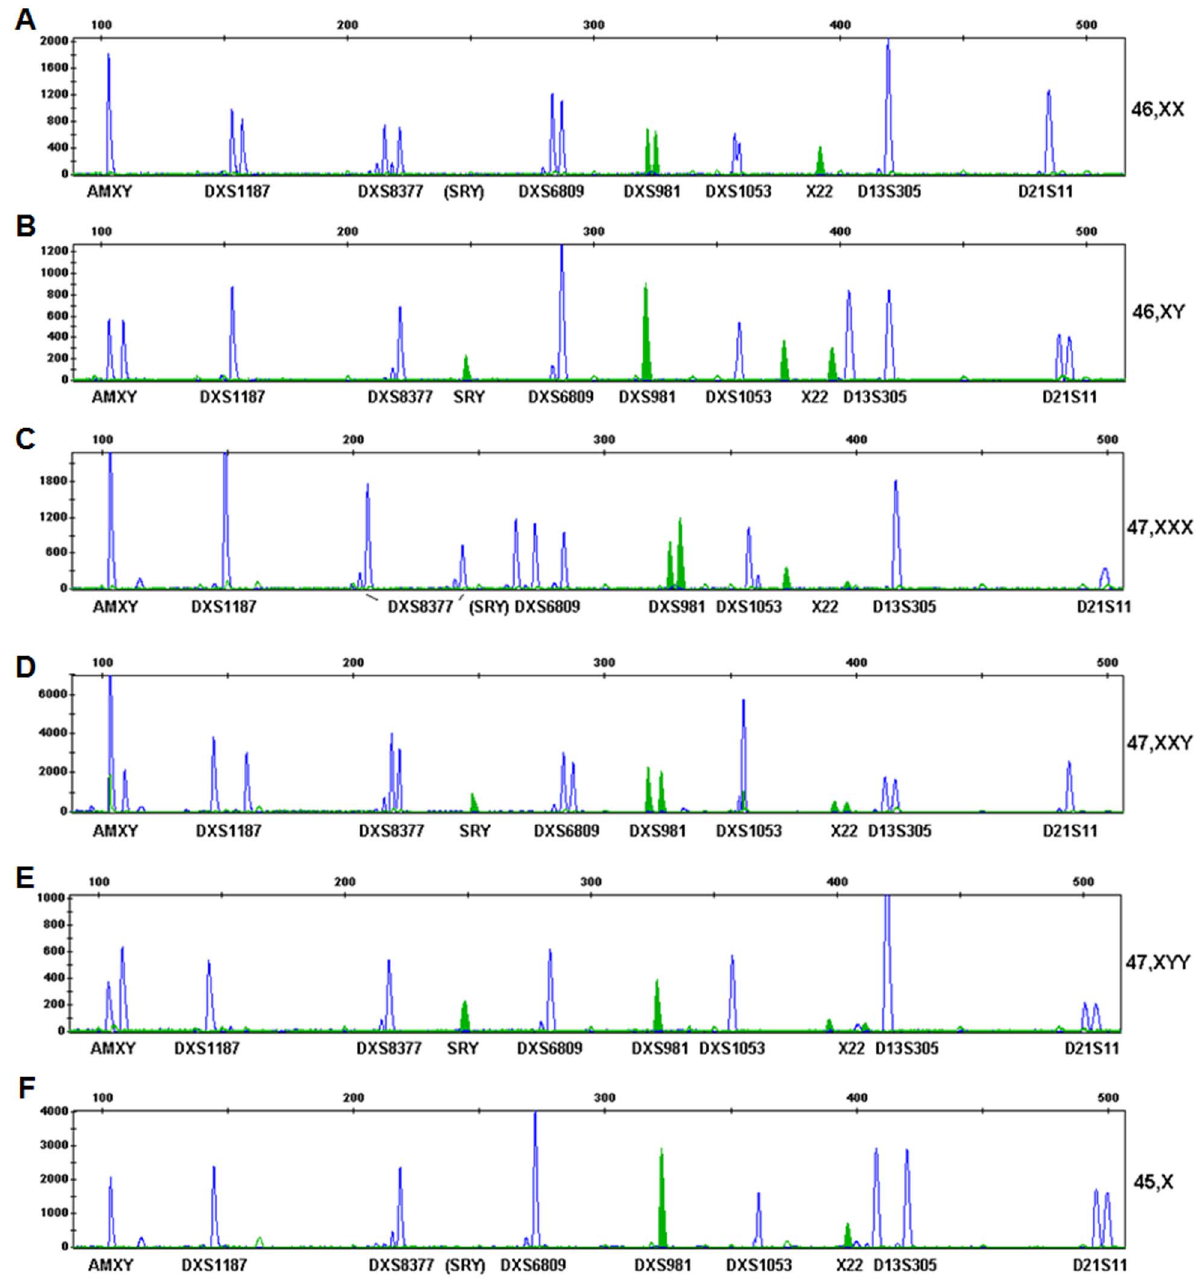
Figure 2. Representative examples for a normal female (A), a normal male (B), a trisomy X (47, XXX) (C), a Klinefelter syndrome (47, XXY) (D), a Jacob’s syndrome (47, XYY) (E) and a Turner syndrome (45, X) (F) obtained through the 10-plex QF-PCR assay. The results are produced using the GeneMapper software, showing full ranges and all sizes of the detected peaks on the vertical and horizontal axes respectively for intuitive intra-sample visual comparison of the peaks. Fragment sizes are shown in bp on the horizontal axis. Arbitrary fluorescence units are shown on the vertical axis.